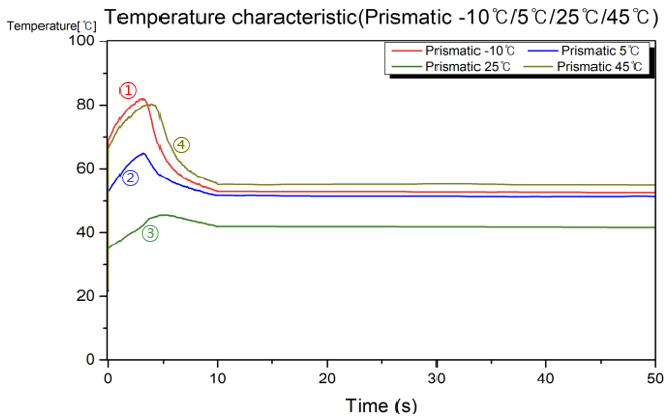
Figure 13. Temperature status of prismatic cell during testing according to preprocessing temperature.